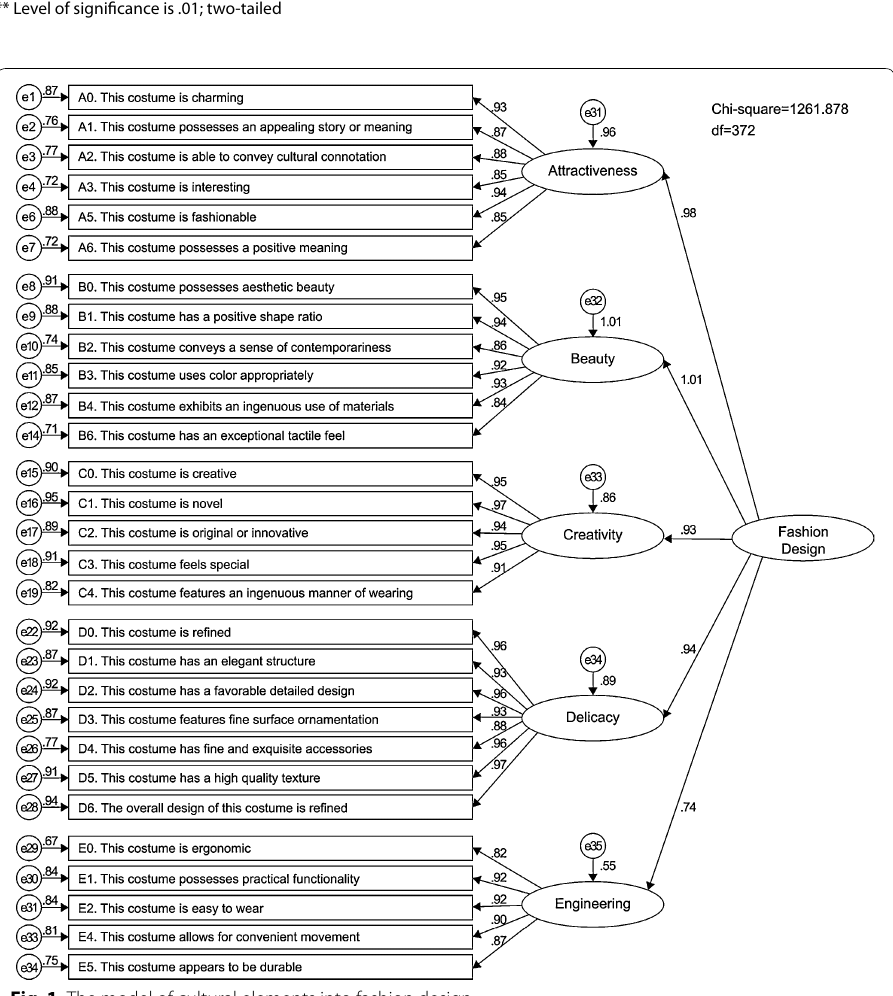
** Level of significance is .01; two-tailed